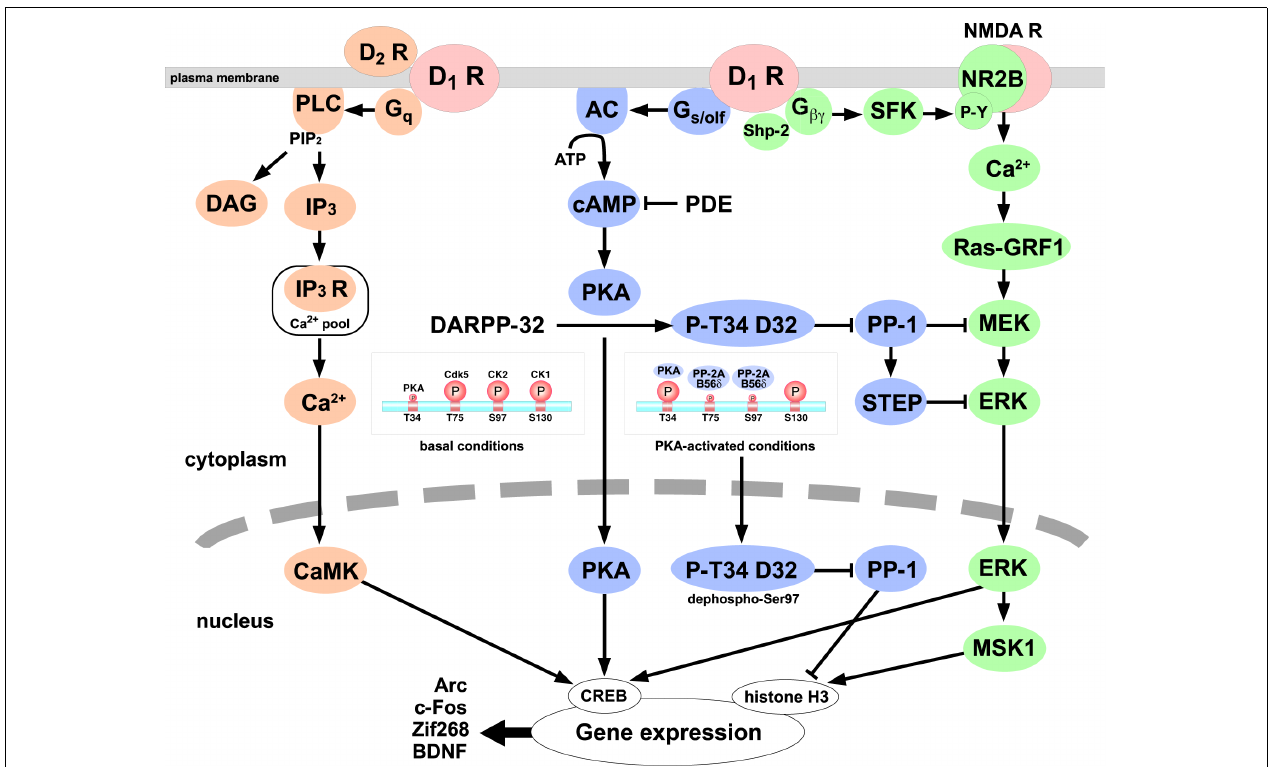
Thr34 and the dephosphorylation of DARPP-32 atThr75 and Ser97 by PP-2A/B56 δ complex, and phospho-Thr34/dephospho-Ser97 DARPP-32 accumulates in nucleus and inhibits PP-1, leading to the increase in histone H3 phosphorylation (Stipanovich et al., 2008). ERK, activated by two D 1 receptor pathways, induces mitogen- and stress-activated kinase 1 (MSK1) activation and histone H3 and cAMP-response element binding protein (CREB) phosphorylation in the nucleus (Girault et al., 2007; Pascoli et al., 2011).Thus, D 1 receptor-mediated activation of PKA, intracellular Ca 2 + , and ERK signaling induces the changes in downstream signaling cascades and the transcriptional activation of many genes. CaMK, Ca 2 + /calmodulin-dependent protein kinase; DAG, diacylglycerol; PDE, phosphodiesterase; STEP, striatal-enriched tyrosine